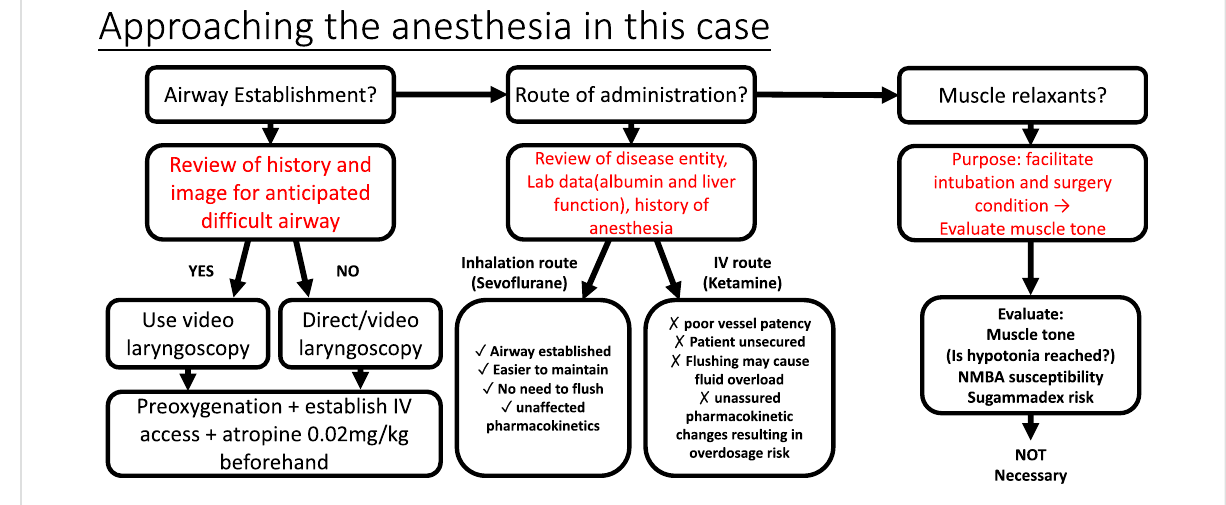
FIGURE 2 Approach to the anesthesia in the case. Secured airway prevents respiratory complications and brain hypoxia in children ’ s anesthesia. After the review of X-ray and evaluating child appearance, video larnygoscopy was chosen for expected dif fi cult airway intubation. Decision of the route of administration depends on the pros and cons. Hypoalbuminemia increases free active fraction of protein-bound drugs; at the same time, elevated liver transaminases/liver pathology may also interfere with drug metabolism, in this case, ketamine. On the other hand, anesthetic sevo fl urane was eliminated directly via lung exhalation, bypassing the liver metabolism. Therefore, the inhalation route outweighed the IV route with its convenience and safety. Muscle relaxants act to facilitate endotracheal intubation and operation; in this case, with hypotonia and the